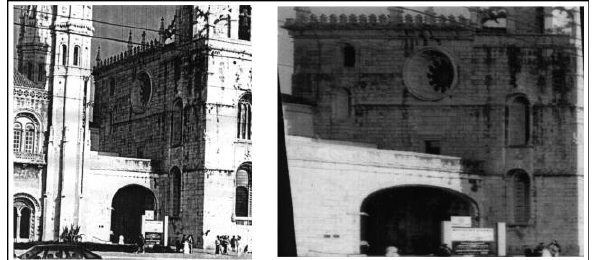
Figura 2. West facade of the church of the monastery of Jerónimos, in Lisbon. Single image photogrammetry (Genin, 1995)